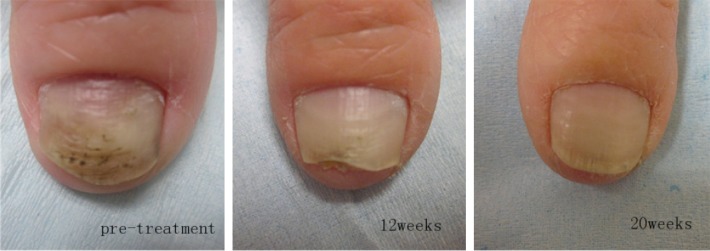
Images before and after four treatment sessions for fingernail onychomycosis.